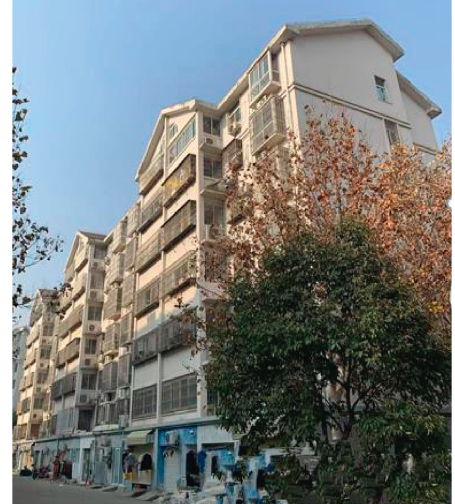
Figure 2: The appearance of a masonry structure.